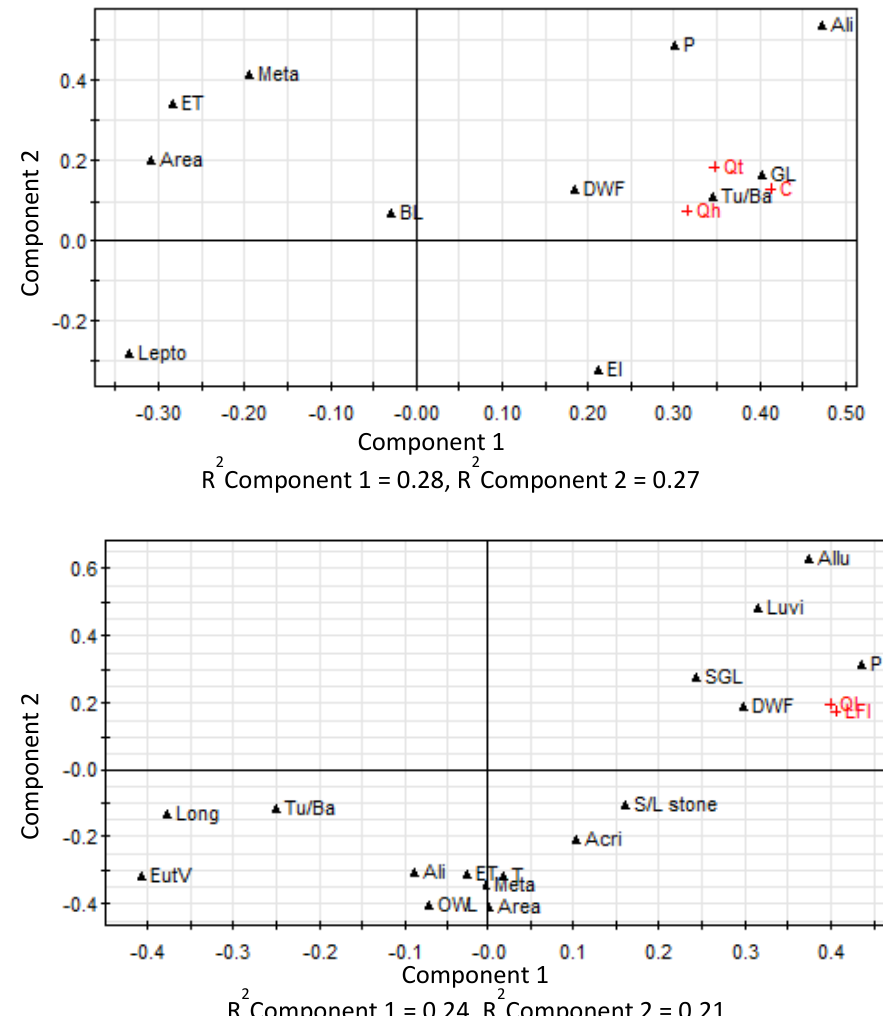
Figure 3. PLS plots for total/high flow group (the first pane) and low flow group (second pane) with watershed (explanatory) variables that were significant at the 90% confidence level in prediction of the hydrological (response) variables. The hydrological variables were indicated with cross signs (+) and the watershed variables with filled triangles (▲). Codes of the variables represent; P - rainfall (mm/yr), T - temperature ( 0 C/day), ET - evapotranspiration (mm/day), El - elevation (m), Tu/Ba - tuffs and basalts, S/L - stone sand/lime stone, Meta - metamorphic rock, Allu - Alluvial, GL - grazing land, OWL - open woodland, DWF - dense wet forest, SGL - savannah grassland, BL - (degraded) bush land, Lepto - leptosols, Acri - acrisols, Ali - alisols, EutV - Eutric Vertisols, Luvi - luvisols, Area - watershed area (km 2 ), Long - Longitude (degree-decimal).